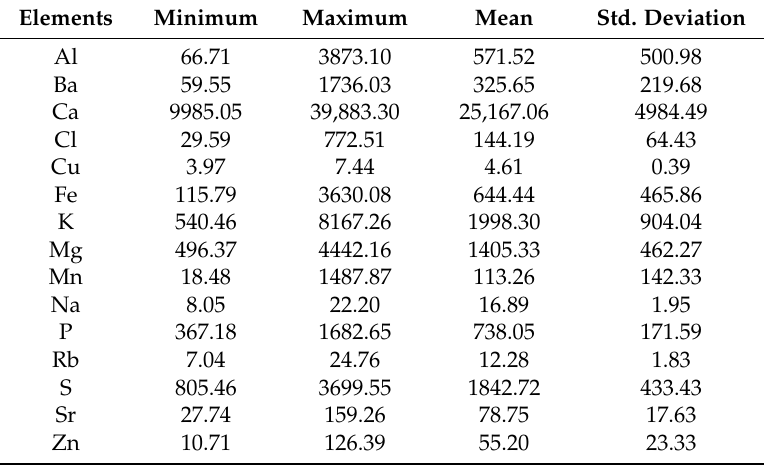
Figure 4. The estimated dose of NO 2 and O 3 for mothers enrolled in the study. Table 3. Descriptive statistics (minimum, maximum, mean, and std. deviation) of trace element levels determined in tree bark (ppm).